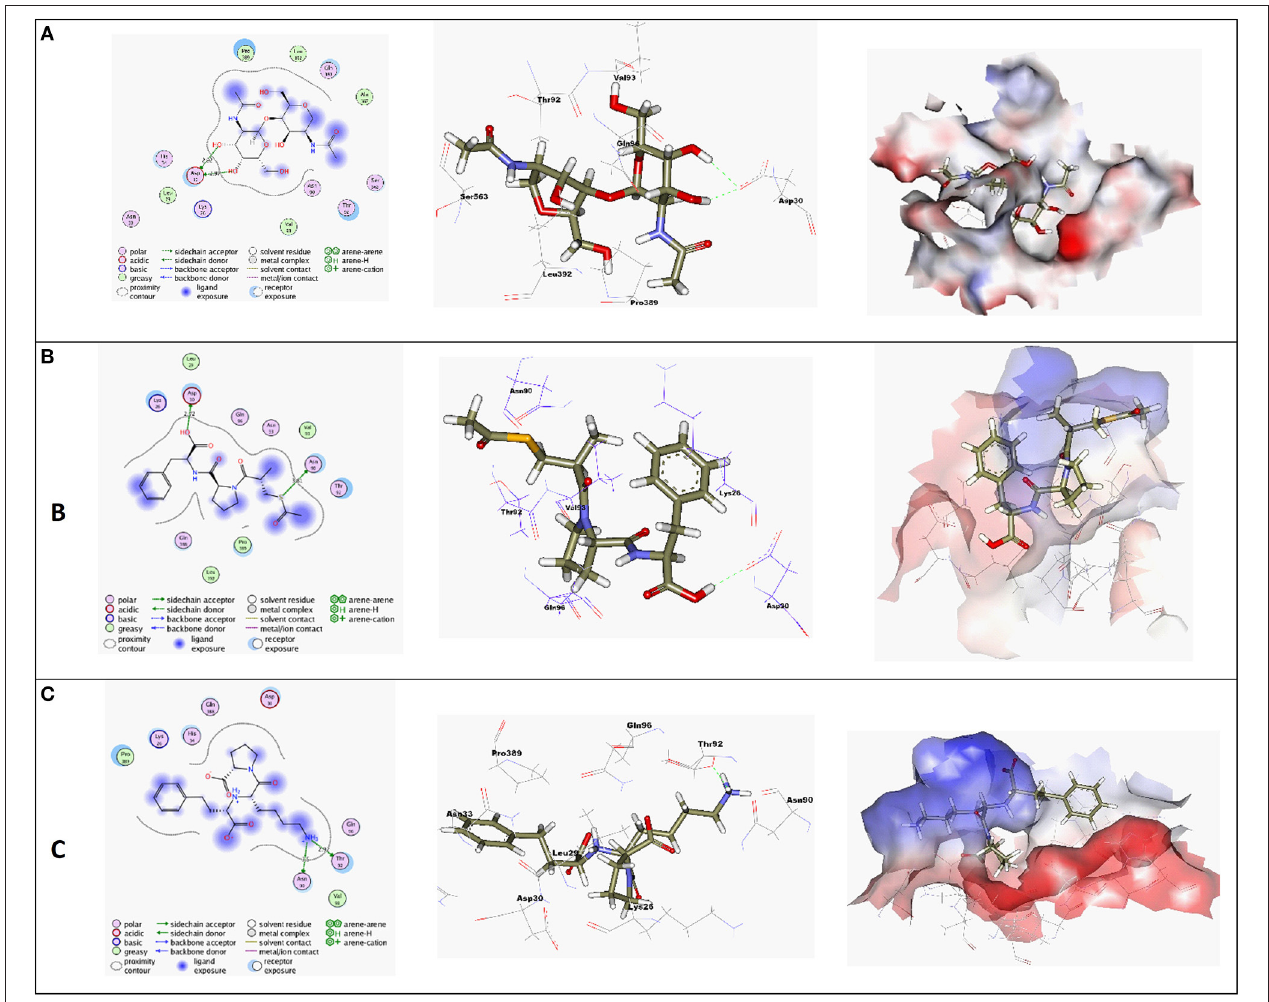
FIGURE 3 | (A) High-resolution crystal structures of coronavirus target explain the native ligand (NAG) in the active pocket (PDB ID: 6VW1, Score = − 4.4, RMSD = 1.3). (B) High-resolution crystal structures of coronavirus target explain Alacepril in the active pocket (PDB ID: 6VW1, Score = − 5.1, RMSD = 1.3). (C) High-resolution crystal structures of coronavirus target explain Lisinopril in the active pocket (PDB ID: 6VW1, Score = − 4.6, RMSD = 1.3). N.B: The surface and maps representations show the H-bond donor, H-bond acceptor, and hydrophobic regions around the docked